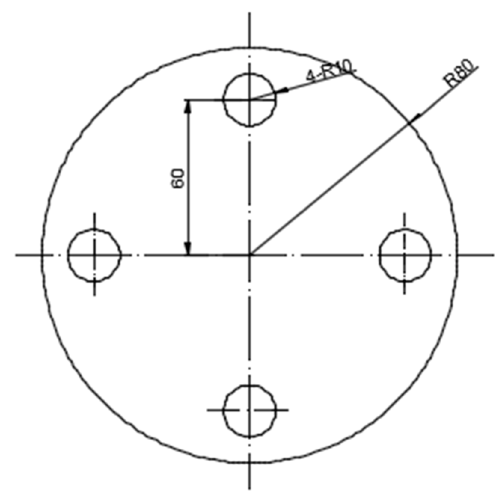
Figure 4. Workpiece dimensions.